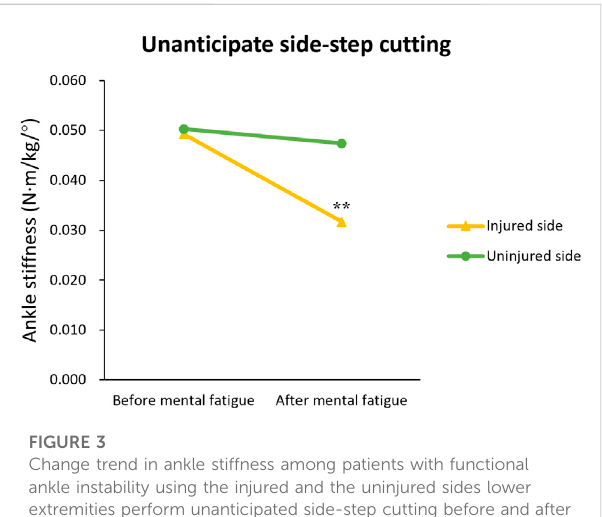
FIGURE 3 Change trend in ankle stiffness among patients with functional ankle instability using the injured and the uninjured sides lower extremities perform unanticipated side-step cutting before and after mental fatigue. “ ** ” means a very signi fi cant statistical difference compared with before mental fatigue ( p <